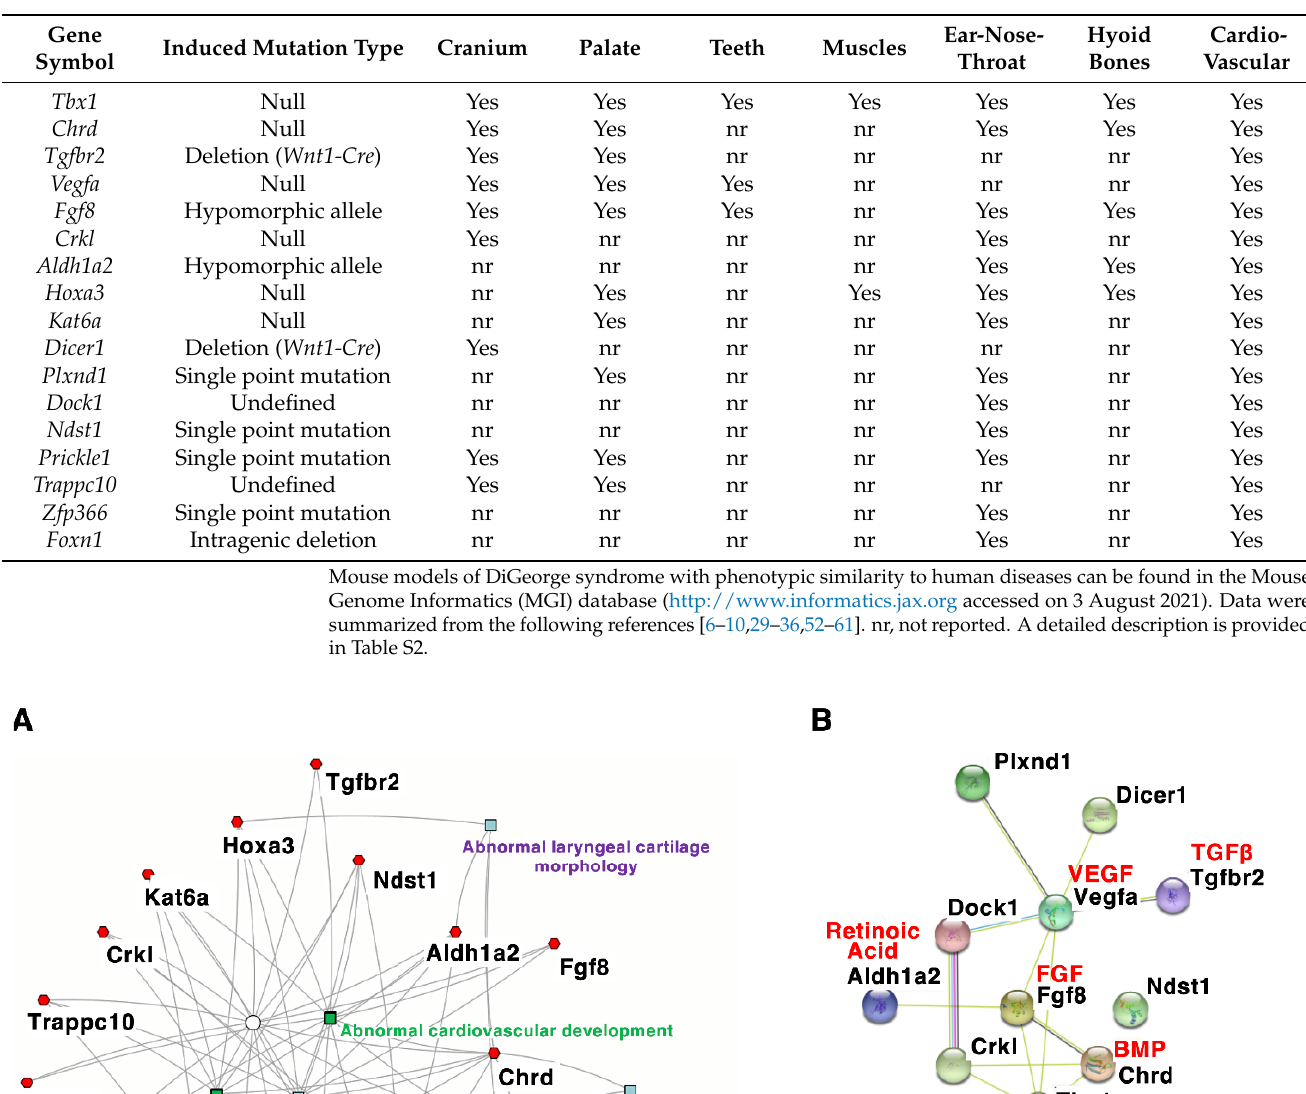
Table 4. Craniofacial phenotypes of DGS/VCFS mouse model.